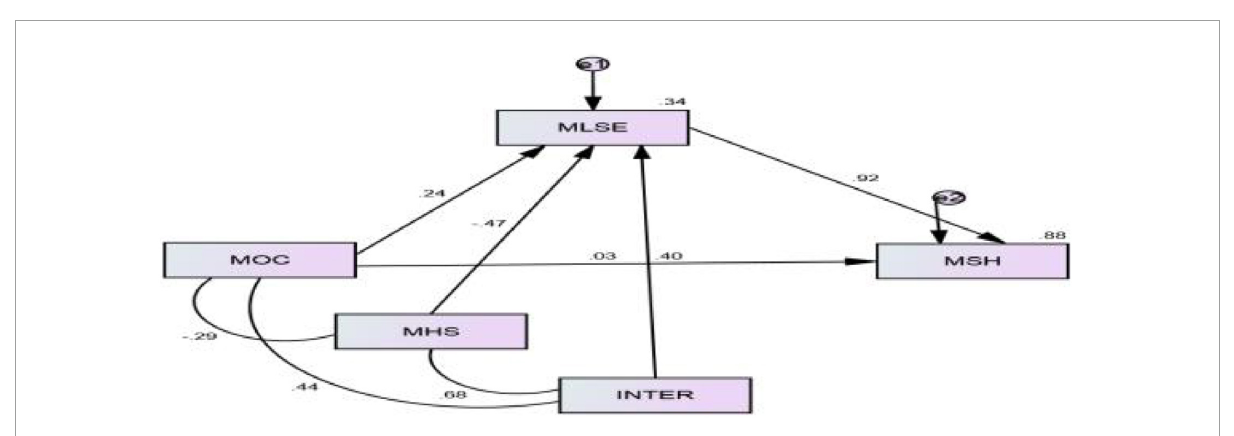
FIGURE3 Structural equation modeling